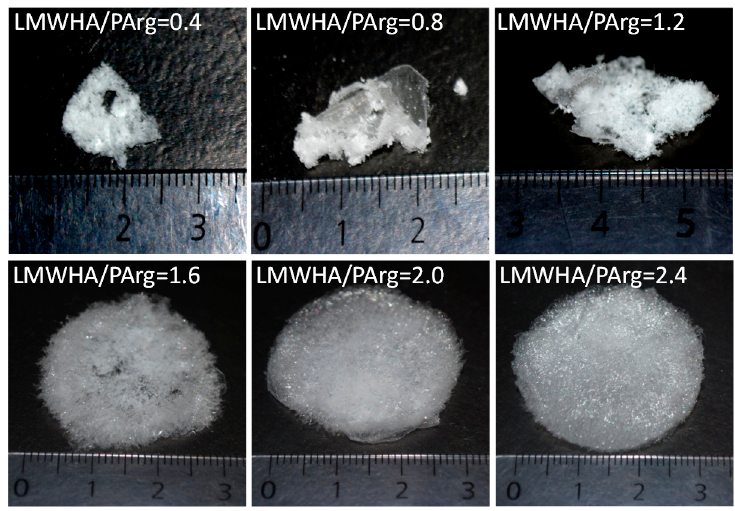
Figure 3. Optical images of materials obtained after freeze-drying 9 mL of INC aqueous suspensions containing LMWHA and PArg at a ratio of 0.4, 0.8, 1.2, 1.6, 2.0, and 2.4 in cylindrical plastic containers with 38 mm diameter.